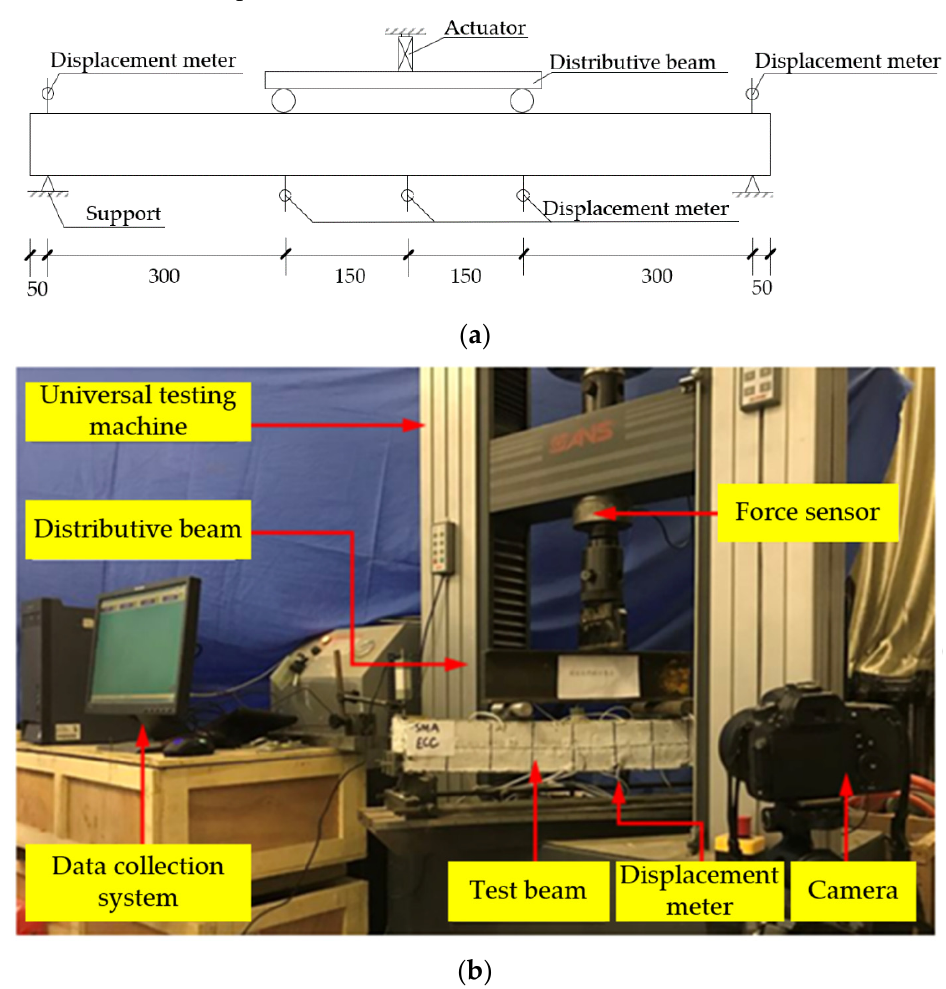
Figure 6. Test setup for quasi-static cyclic tests. ( a ) Sketch of the test loading device. ( b ) Photograph of the test setup.